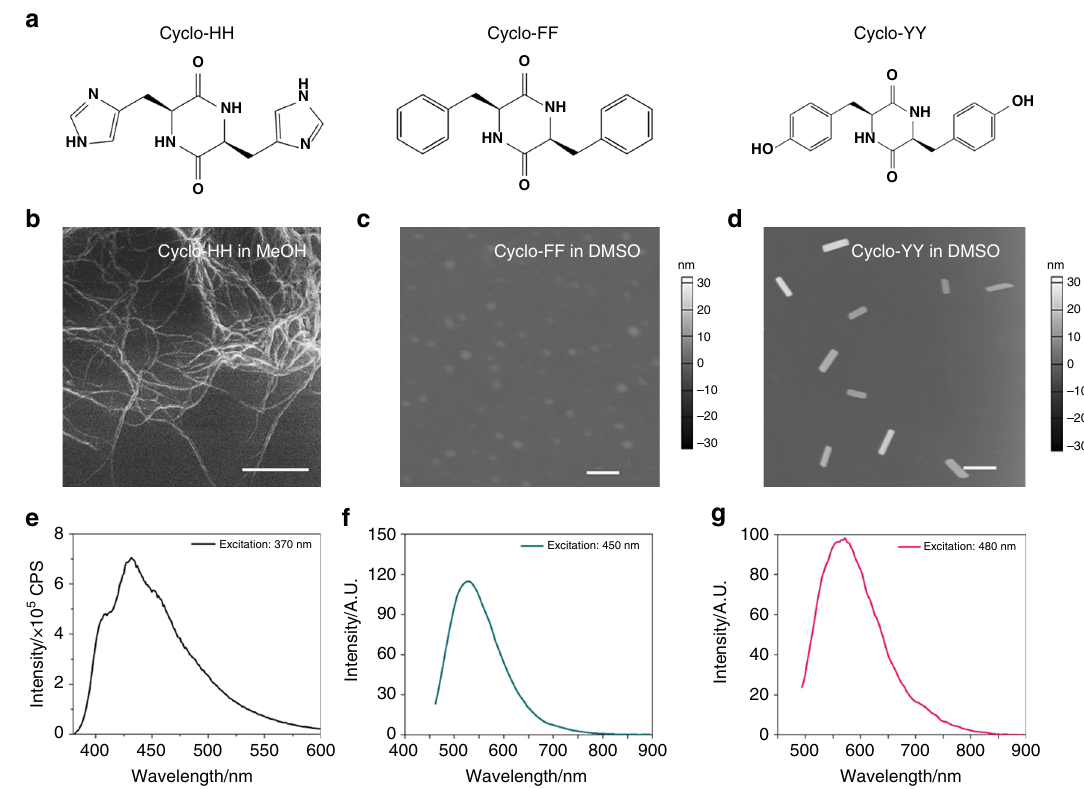
Fig. 7 The effect of diverse aromatic side-chains. a Molecular structures of cyclo-HH, cyclo-FF, and cyclo-YY. b – d Microscopic images showing the self-assemblies of ( b ) cyclo-HH in MeOH (scale bar: 1 μ m), ( c ) cyclo-FF in DMSO (scale bar: 50 nm), and ( d ) cyclo-YY in DMSO (scale bar: 500 nm). e – g Fluorescent emission of ( e ) cyclo-HH in MeOH, ( f ) cyclo-FF in DMSO, and ( g ) cyclo-YY in dots for cyclo-HH, cyclo-FF, and thin nano fi bers for cyclo-YY